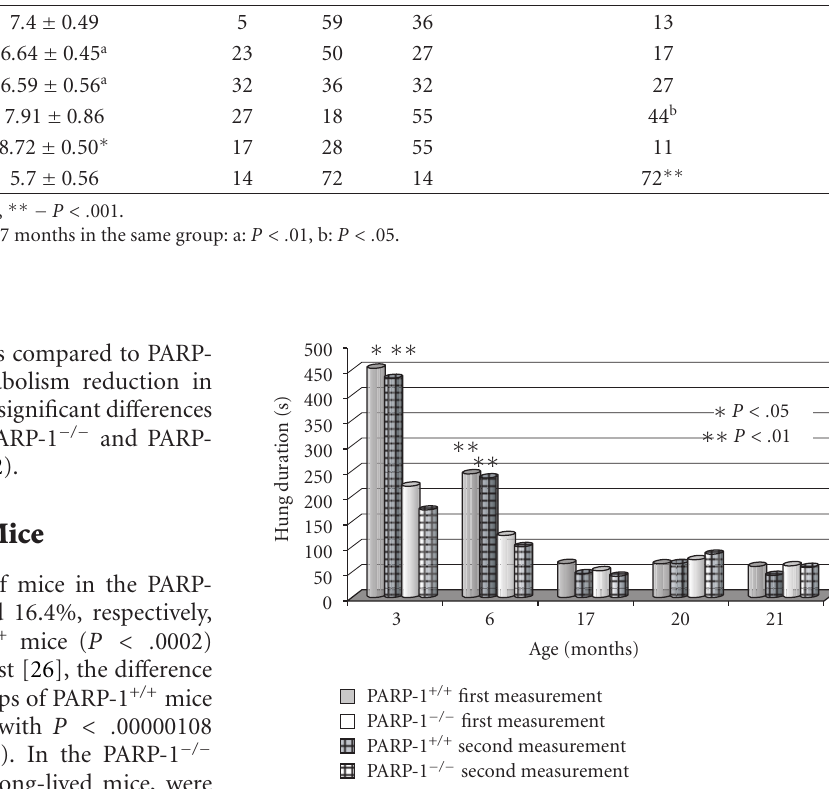
Figure 6: Age-related holding strength of PARP-1 − / − and PARP- 1 + / + mice. The hung on the string duration of PARP-1 − / − and PARP- 1 + / + mice was tested at the ages indicated by their holding a string, and the duration (in second) of holding a string was